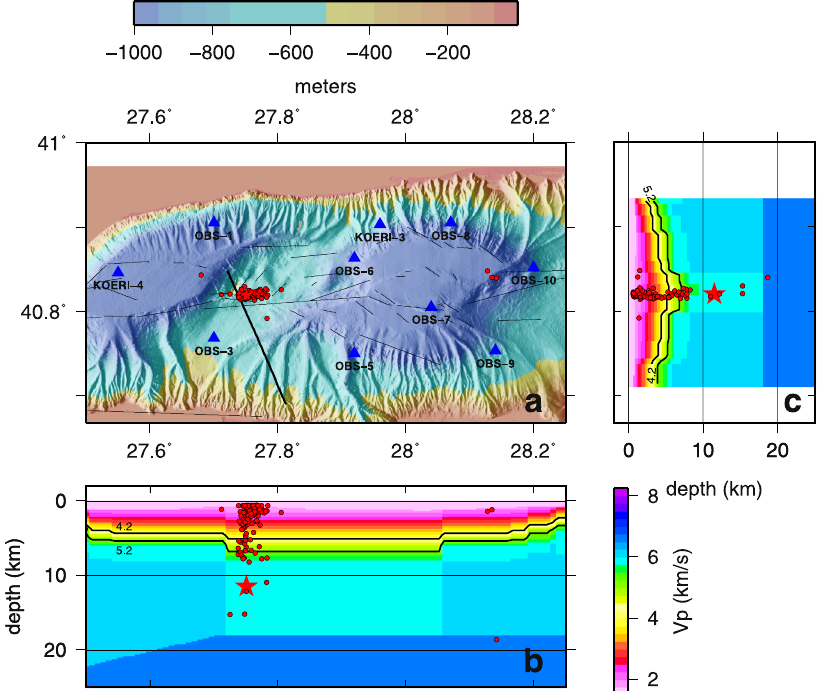
Figure 2. Panel a displays hypocenter relative locations (red dots) for the aftershocks that followed the M 5.1 earthquake of July 25, 2011. Locations were obtained using manual picks and the high-resolution P-wave velocity model described in Appendix 1. Triangles indicate OBS locations. Thick black line indicates the seismic profile collected in 2001 during the Seismarmara Cruise 28,36 shown in Fig. 5. Thin black lines are for active faults 7 . Panels b anc c display the cross-sections of depth below sea-level along an East-West line crossing at 40.80°N and along a North-South line crossing at 27.78°E, respectively, with the aftershocks and the velocity structure extracted from the P-wave velocity grid (Appendix 1). The two iso-velocity lines at 4.2 and 5.2 km/s correspond to the syn-kinematic and post-kinematic basement, respectively 28,31 . Red star indicates the absolute location of the M w 5.1 earthquake (the position obtained with land and sea-bottom stations is consistent within 0.5 km with the position obtained using OBSs only). First, absolute locations of all the events of the aftershock sequence were obtained using the NonLinLoc 33 software package. Then relative locations were computed using NonLDiffLoc 33 on a selection of “well-constrained” events, e.g.: number of stations ≥ 7; RMS < 250 msec; gap ≤ 150°; error in depth smaller than z. Image created with GMT software, Version